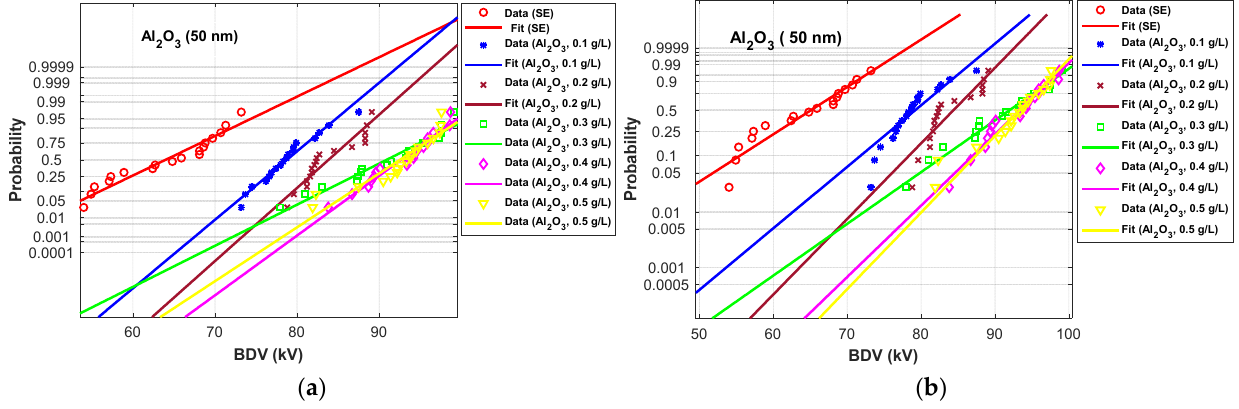
Figure 16. Probability plot of breakdown voltage data of SE-based nanofluids with Al 2 O 3 (50 nm) for the 2 mm electrode gap; ( a ) normal and ( b ) extreme value. Table 5. The AC BDV at 1, 10, and 50% probability levels evaluated from normal and extreme value fit